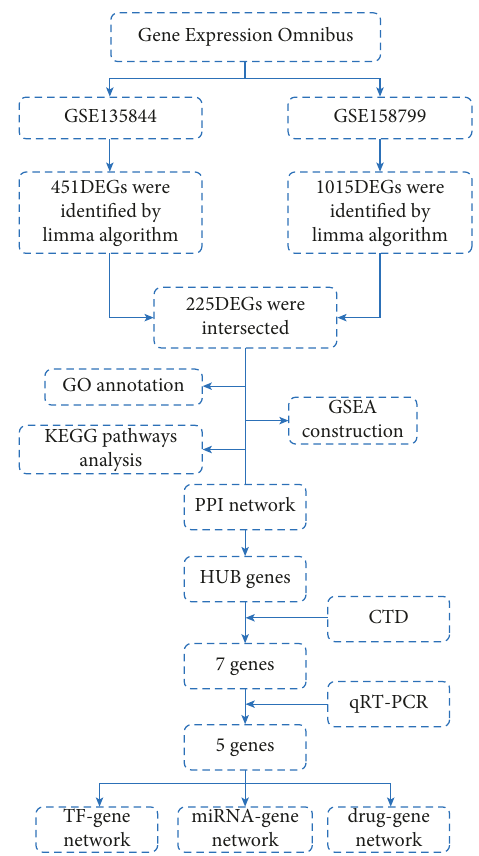
Figure 1: The flowchart of the research process. GO, Gene On- tology; GSEA, gene set enrichment analysis; KEGG, Kyoto Ency- clopedia of Genes and Genomes; PPI, protein-protein